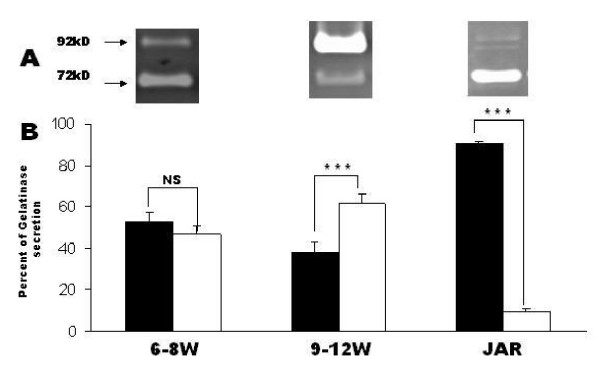
(A) Representative secretion pattern of proMMP-2 (72 kD) and proMMP-9 (92 kD) in 6–8 w, 9–12 w trophoblasts and in JAR cells without treatment as examined with zymography. (B) Bar graph describing the relative percentage of gelatinases secretion, representing mean ± SEM from 5 independent experiments. Black bars represents proMMP-2 and white bars represent proMMP-9, *P < 0.05.